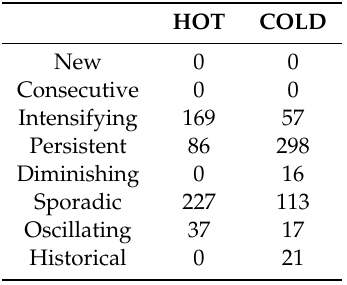
Table 5. Analysis summary of emerging hot spot level 1 results.